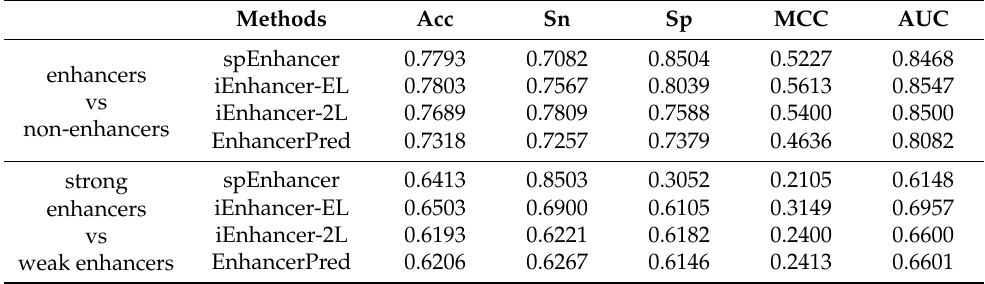
Table 4. Comparison of the results of the leave-one-out method on the training dataset between spEnhancer and the three existing methods.